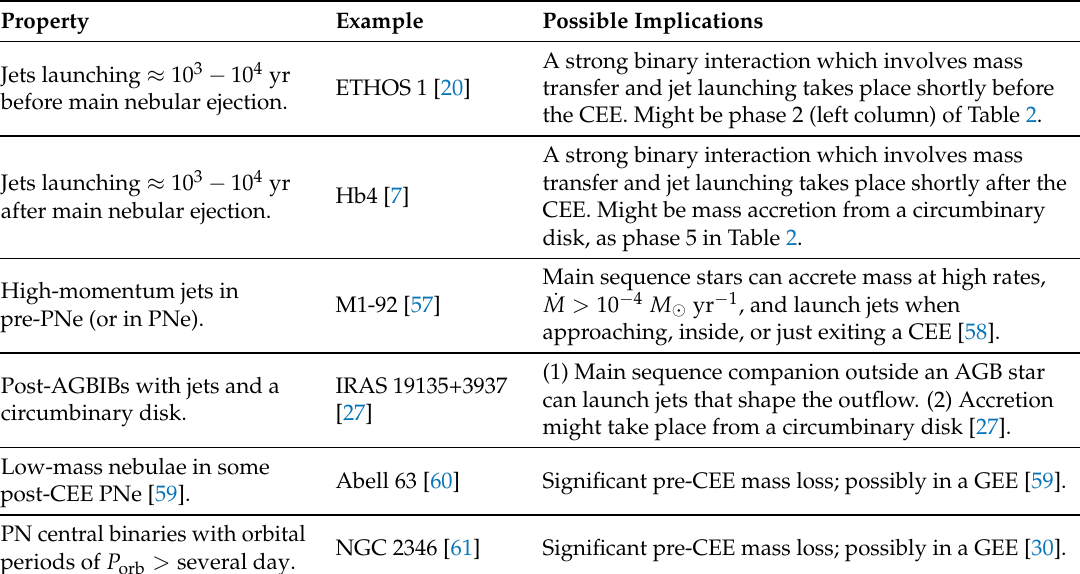
Table 3. Observational indirect support for the importance of the